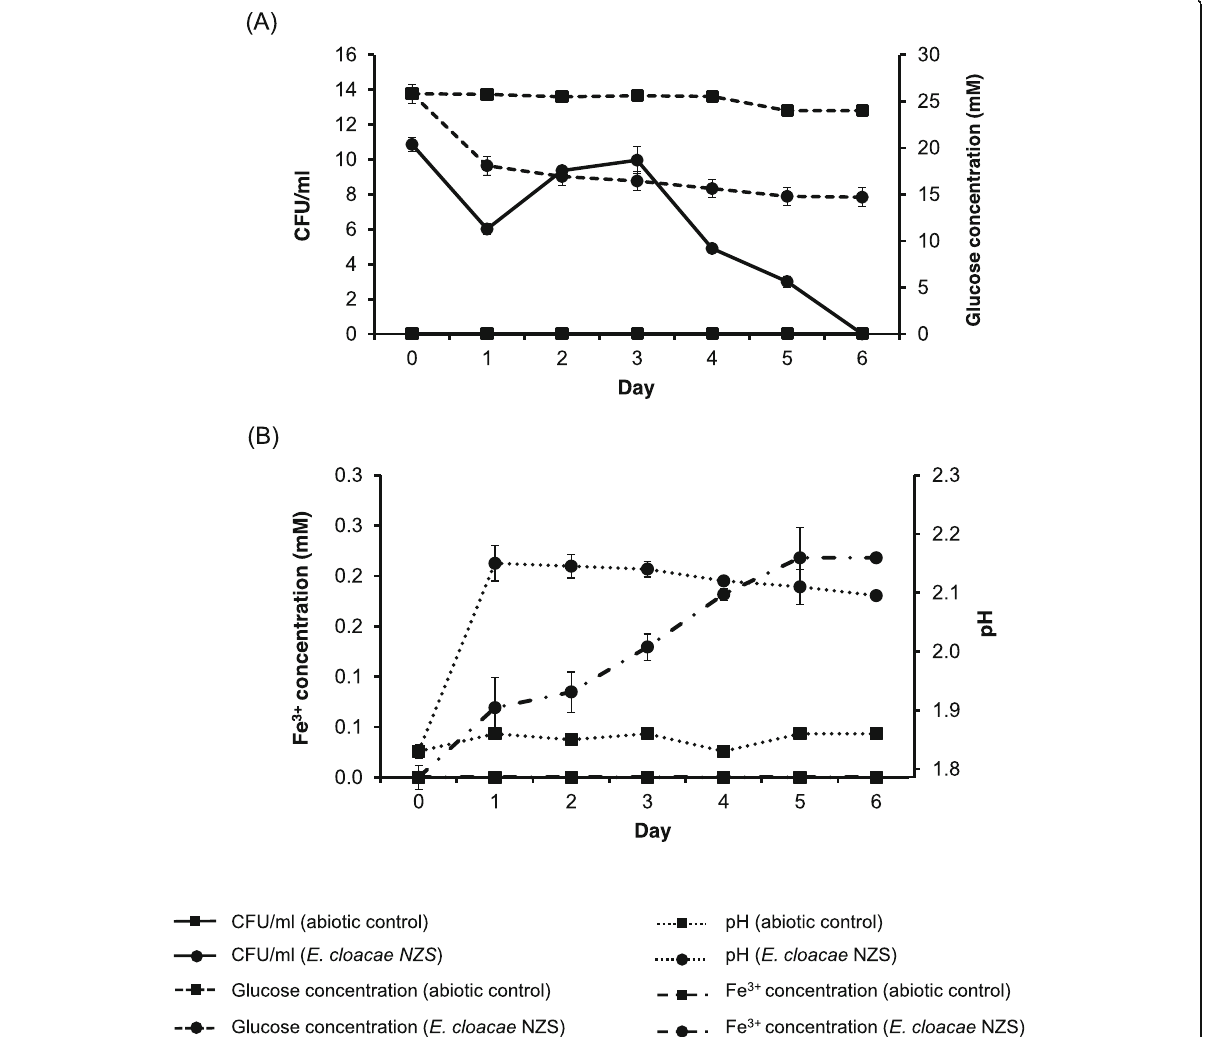
Fig. 4 Assessment of E. cloacae NZS in terms of a growth and b iron (III) produced during oxidation of iron (II) to iron (III) in 9K media at pH2. Cells were cultivated at pH 2 in 9K media containing 5 g/L glucose with and without FeSO4, at 30 °C at 200 rpm for 6